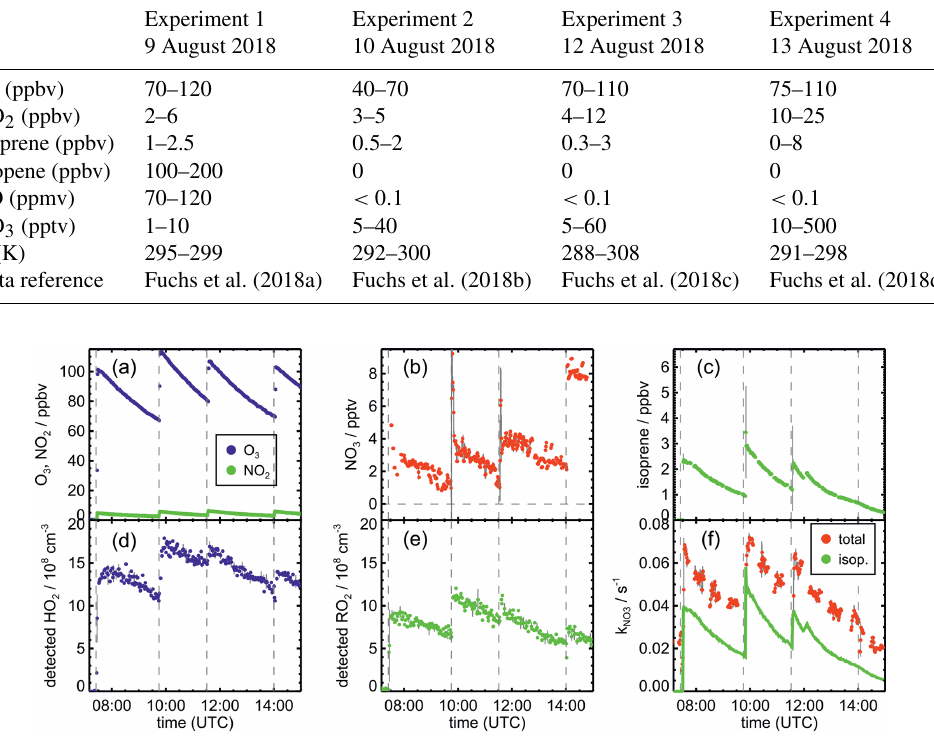
Figure 1. Measurements of radical and trace gas concentrations and NO 3 reactivity in the experiment on 9 August 2018 (Experiment 1) investigating the oxidation of isoprene (isop.) by NO 3 . Between 100 and 200ppmv propene was present to produce HO 2 radicals by its ozonolysis. OH radicals, which are produced in the ozonolysis reaction, are rapidly converted to HO 2 in the reaction with 70 to 120ppmv CO that was injected at the start of the experiment. OH reactivity was dominated by the high CO concentration and is not shown. NO 3 reactivity does not include reactivity from organic radicals and NO 2 . NO 3 reactivity from isoprene is calculated from measured isoprene concentrations and reaction rate constants recommended in the literature (Mellouki et al., 2021). The difference between measured reactivity and reactivity from isoprene can be attributed to propene in this experiment. Observed RO 2 radicals only include a fraction of the total RO 2 because the laser-induced fluorescence (LIF) instrument cannot detect all RO 2 species formed in the reaction of isoprene with NO 3 (Vereecken et al.,